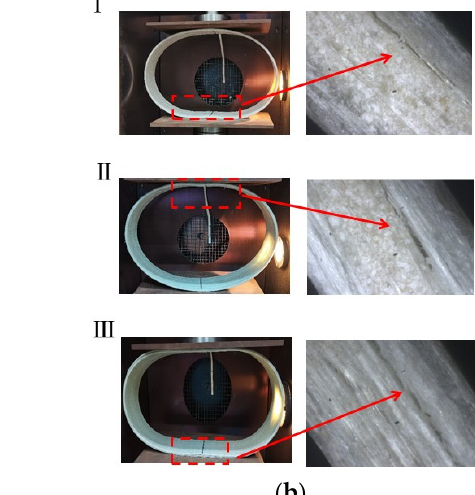
at 70 ◦ C ( a ) Load–displacement curve for GFRP pipes at; ( b ) Failure